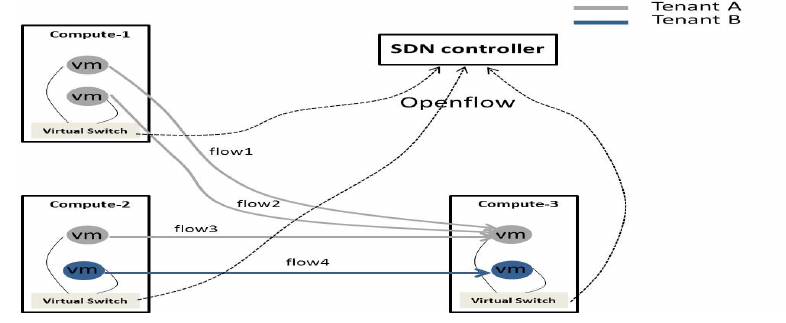
Figure 7. The flow status of tenant